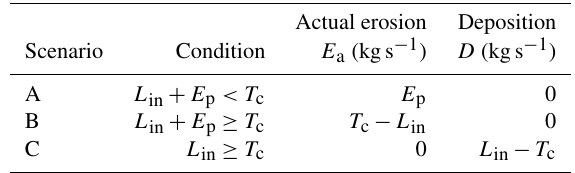
Table 1. Determination of erosion and deposition. Actual erosion